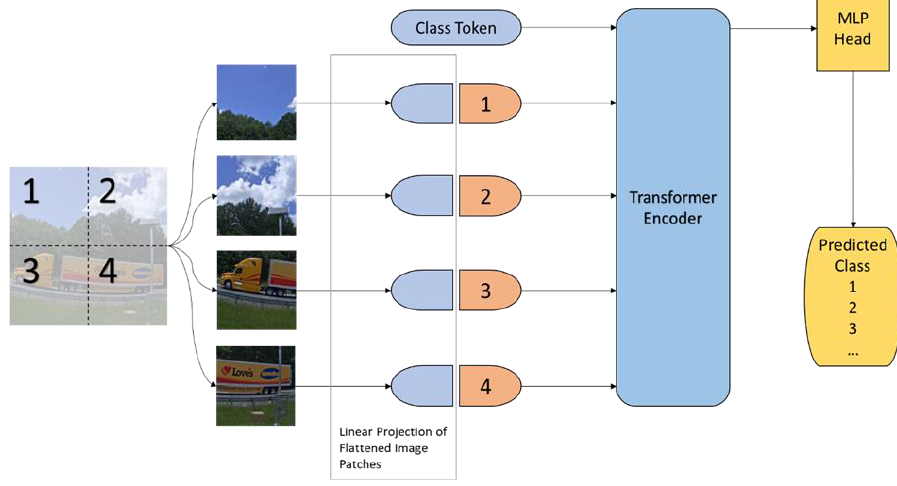
Figure 3. Illustration of wheel positional feature extraction (D1, D2, D3, and D4 are the center-to-center horizontal distances between two successive wheels from left to right).